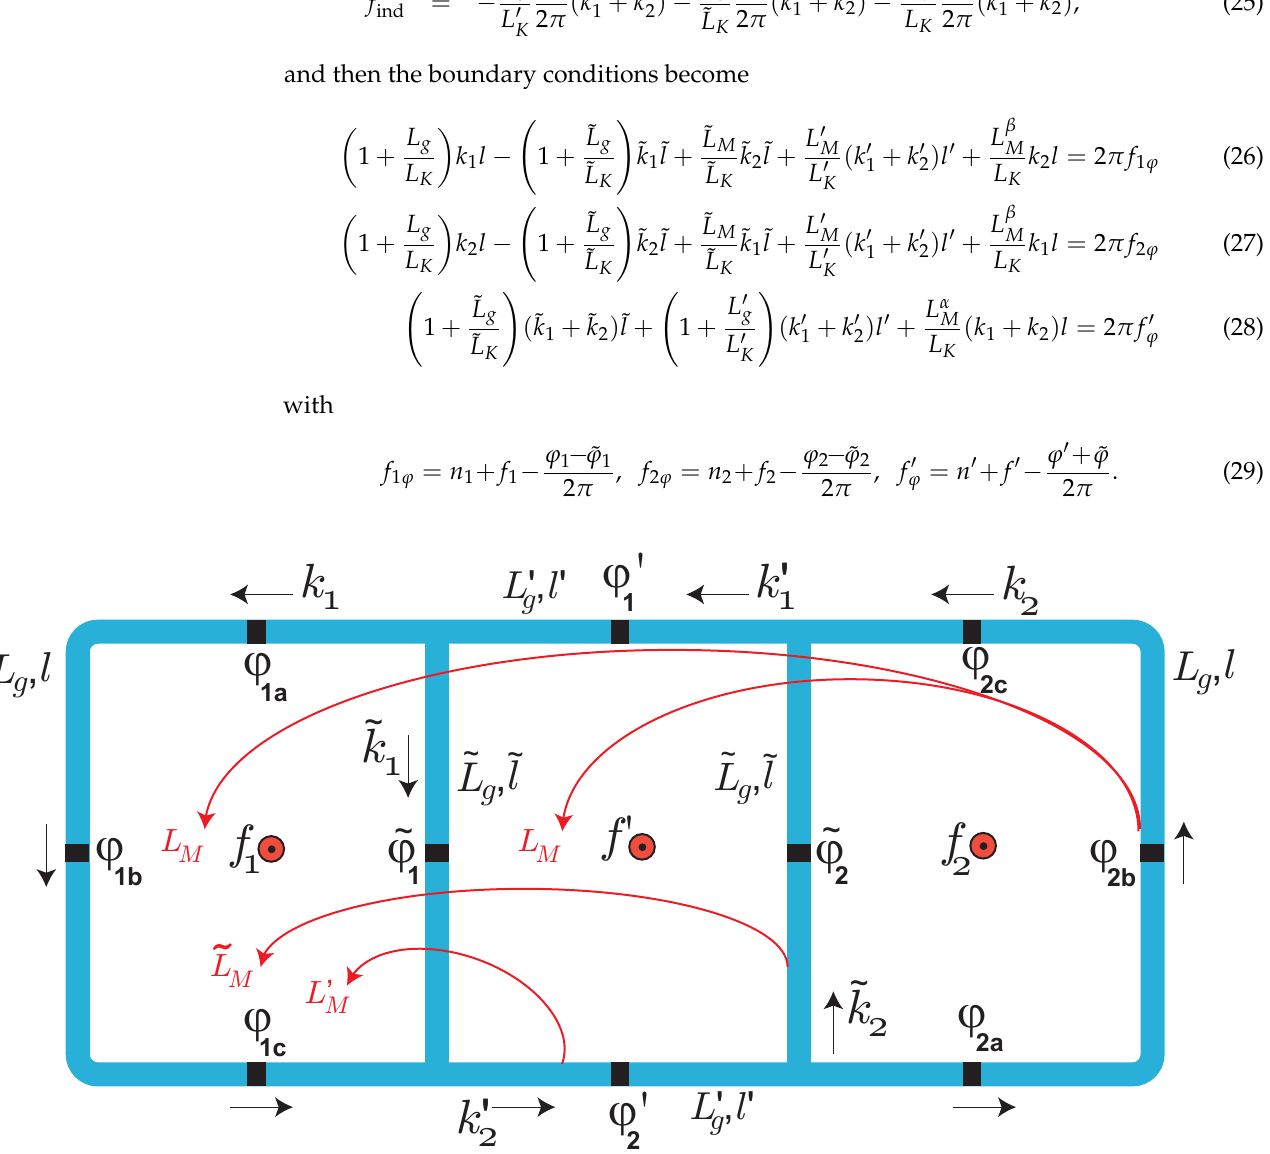
Figure 2. Two flux qubits are coupled through a central connecting qubit loop. Here, ˜ L g and L (cid:48) g are self-inductances and L α , L β , ˜ L M and L (cid:48) are mutual M M M